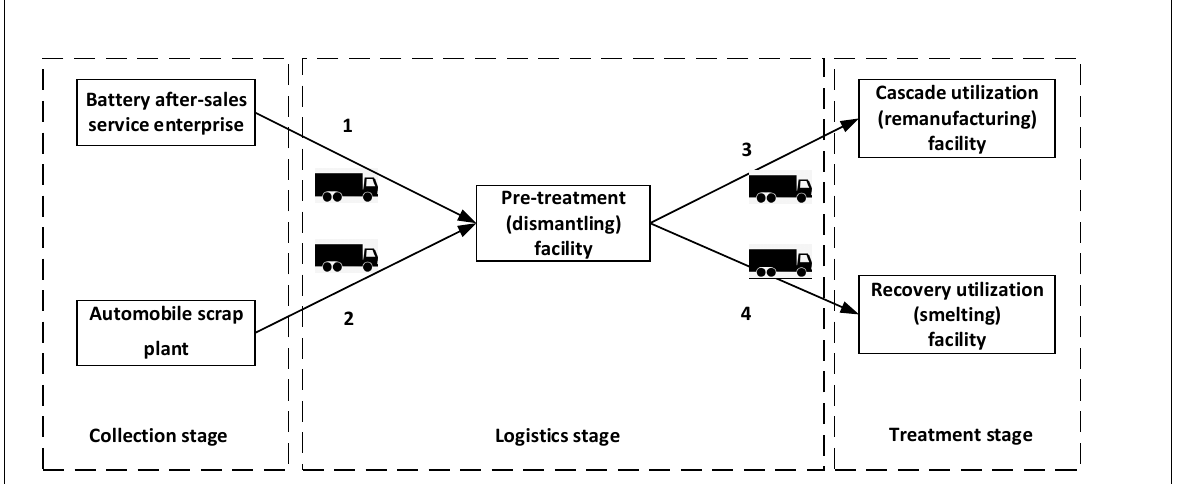
Figure 2. The logistical flow for waste-LIB recycling.